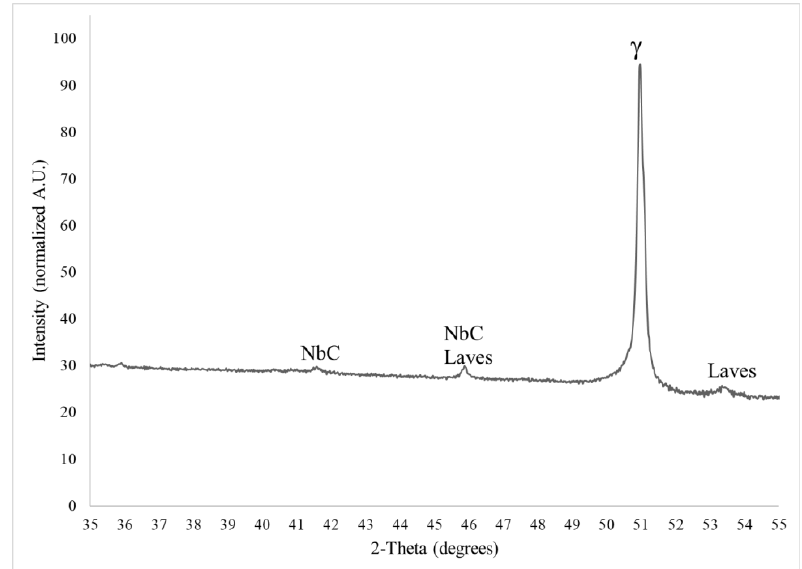
Figure 3. XRD analysis of AB Inconel 718 specimen.